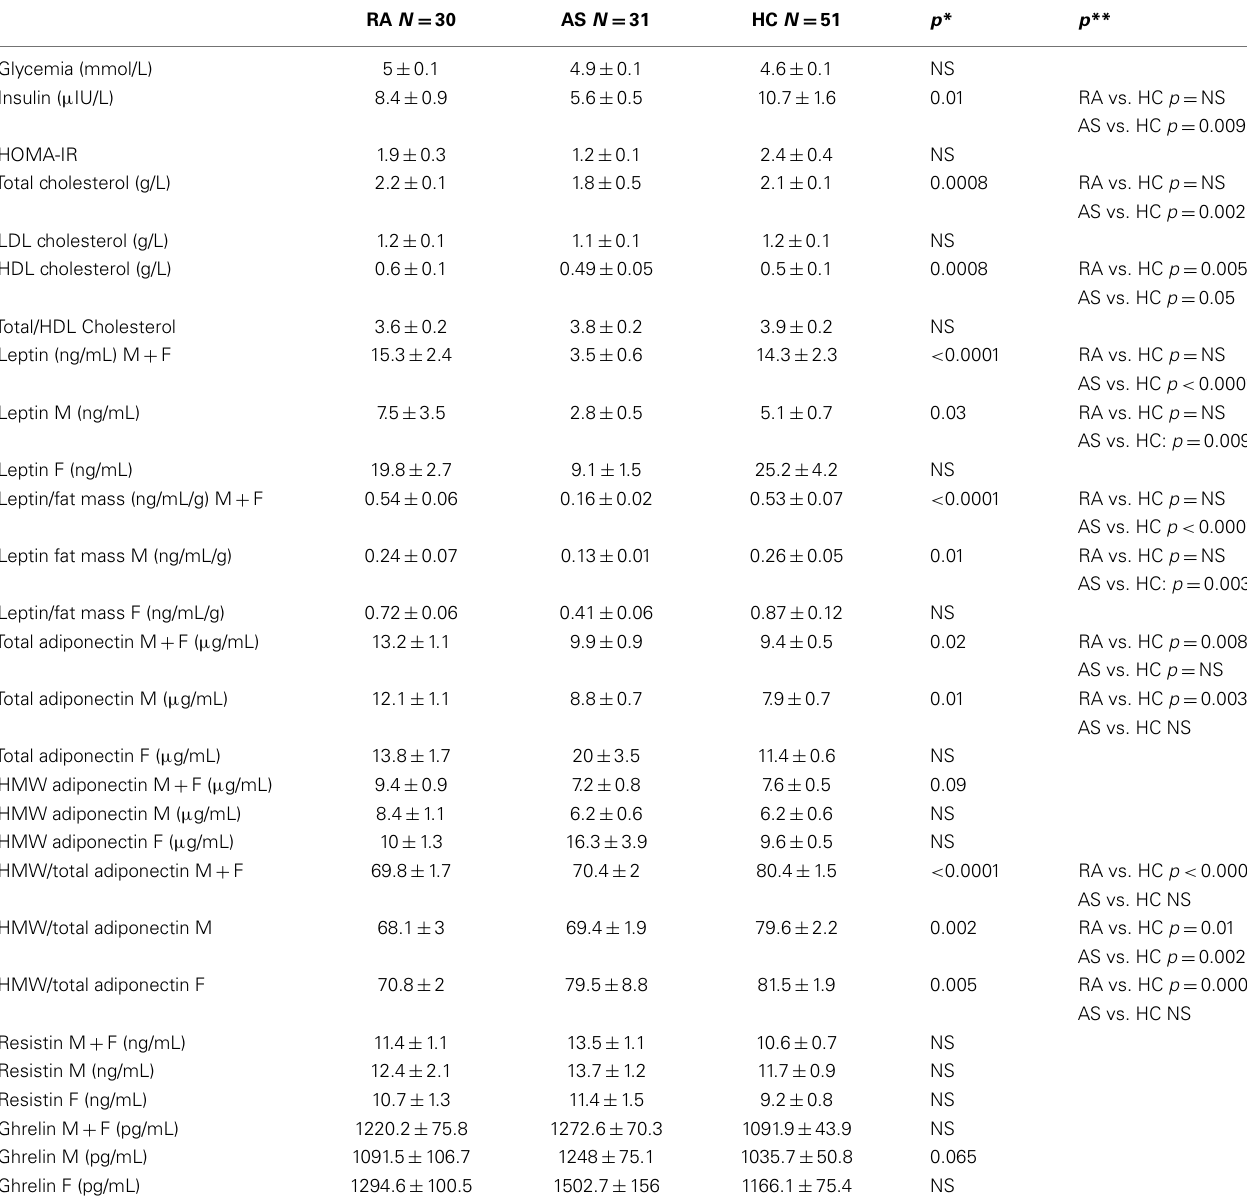
Table 2 | Metabolic parameters, serum ghrelin and adipokine levels of patients with rheumatoid arthritis (RA), ankylosing spondylitis (AS), and healthy controls (HC) (M, male; F, female; *Kruskal–Wallis test; **Mann–Whitney test)